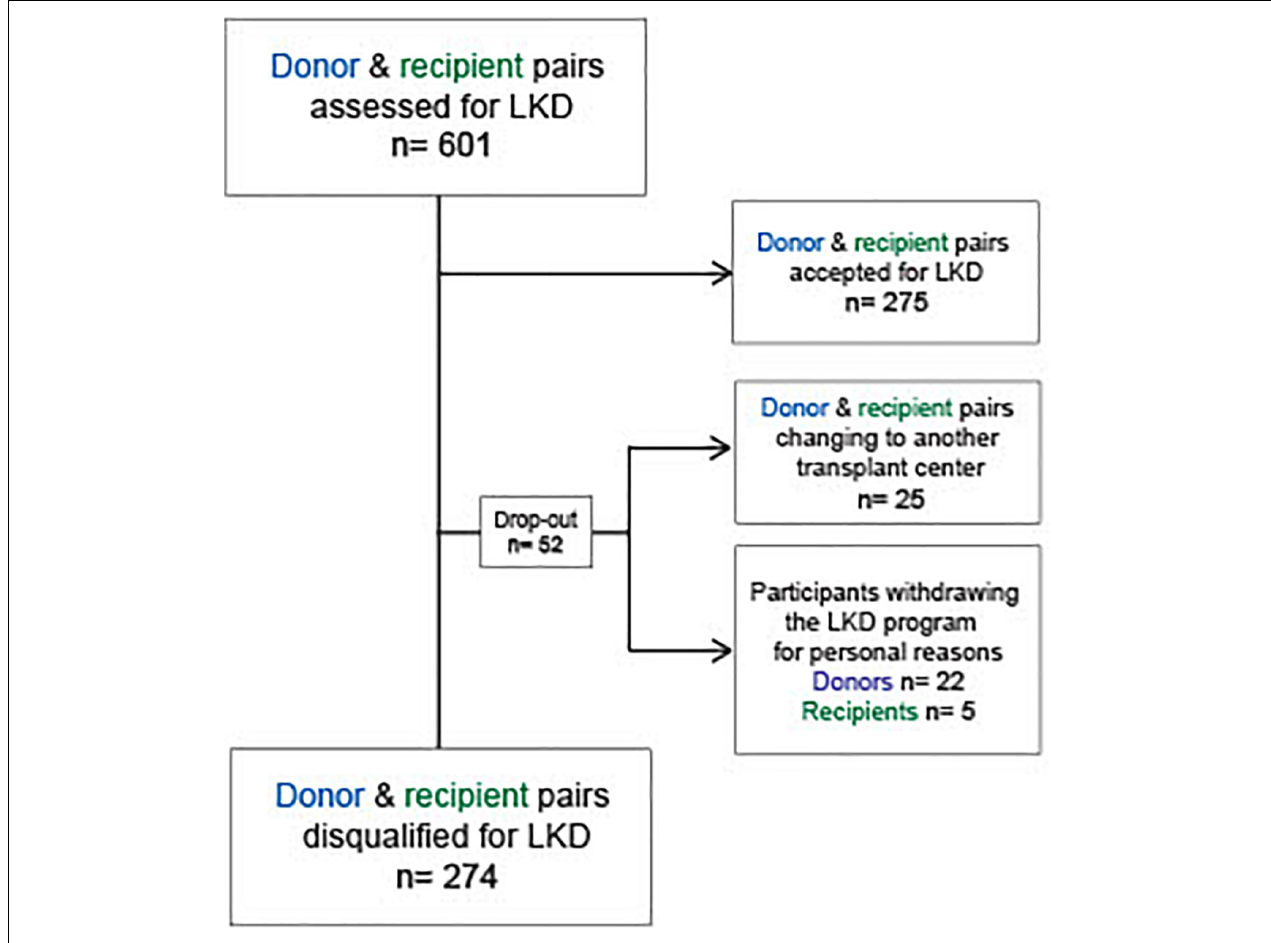
FIGURE 2 | Flow diagram: Study design. LKD, living kidney donation; n,